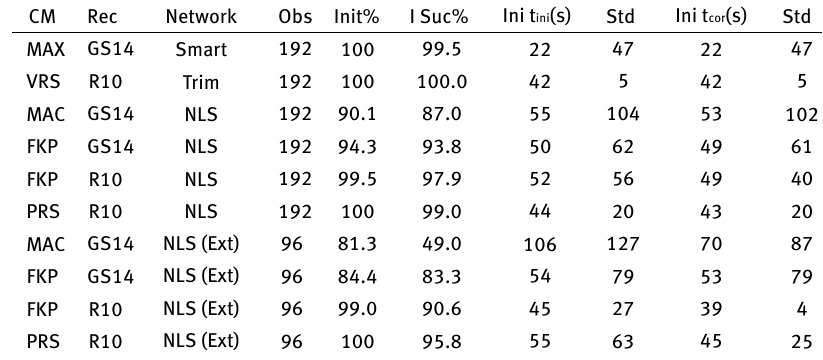
Table 2: Initialization times and their success rates. Initialized observations include all those observations where the receiver indicated a successful initialization. A false initialization means an observation where the plane accuracy is worse than 10 cm despite that the receiver informed that the initialization was successful. Correct observation is an initialized observation where the plane accuracy is better than 10 cm. All percentages have been calculated from the total number of observations (Obs). CM refers to the correction method, Rec to the re- ceiver and Network to the NRTK service provider (Ext refers to the NLS network in an extrapolation mode). Init% tells the percentage of fixed initializations and I_Suc% tell the percentage of correct initializations. Init ini and Init cor give the initialization times of fixed and correctly fixed initializations, respectively, accompanied with their standard